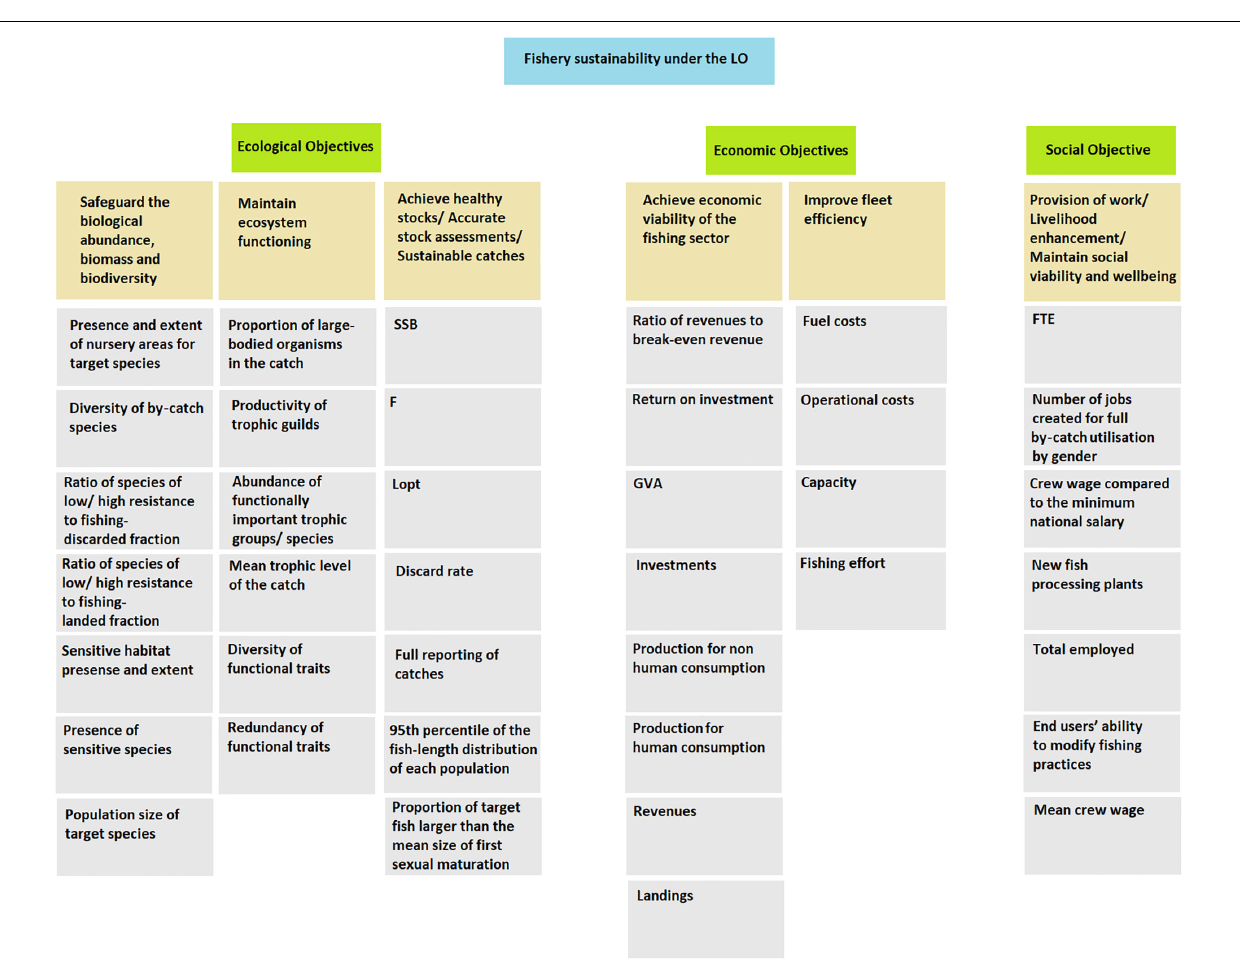
FIGURE 2 | Hierarchical tree of the goal, objectives, and indicators of the fishery sustainability under the LO. F, Fishing mortality; SSB, Spawning Stock Biomass; Lopt, Optimum length; GVA, Gross value added; FTE, Full time